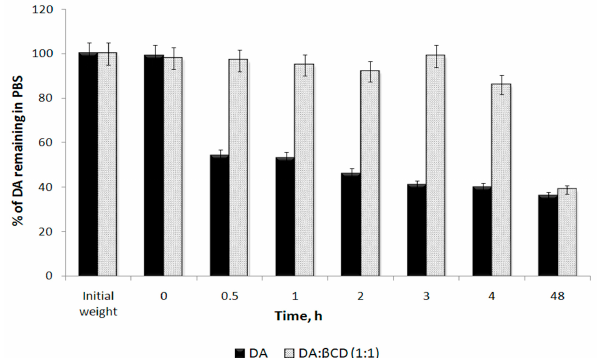
Figure 12. The percentage of DA remaining in PBS solutions of free DA and DA: β CD compounds after HPLC analyses.